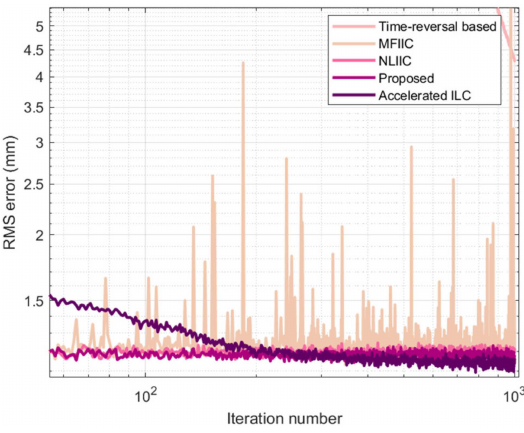
Figure 9. Error curve of iterative learning process.